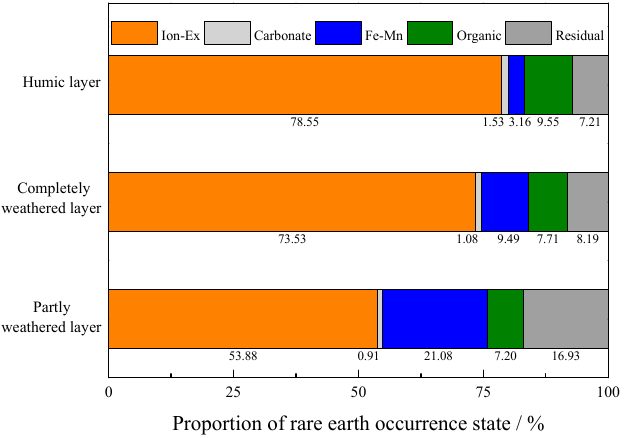
Figure 3. Proportion of rare earth occurrence state in each weathered layer.